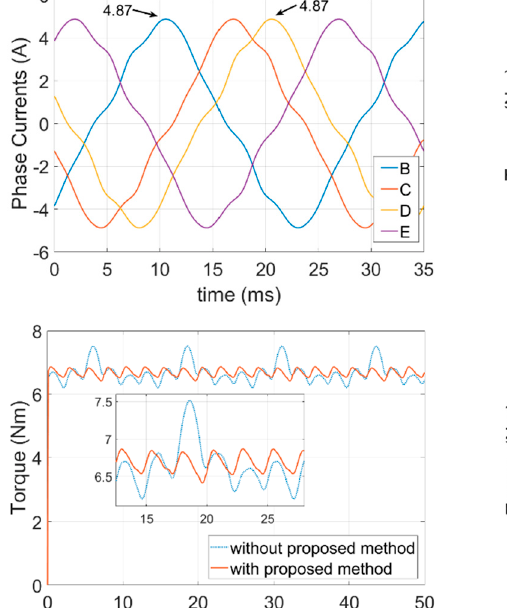
Figure 12. FEA torque waveforms for the fault-tolerant control currents of the SPOC condition with and without proposed method: ( a ) Only fundamental; ( b ) fundamental plus third harmonic.